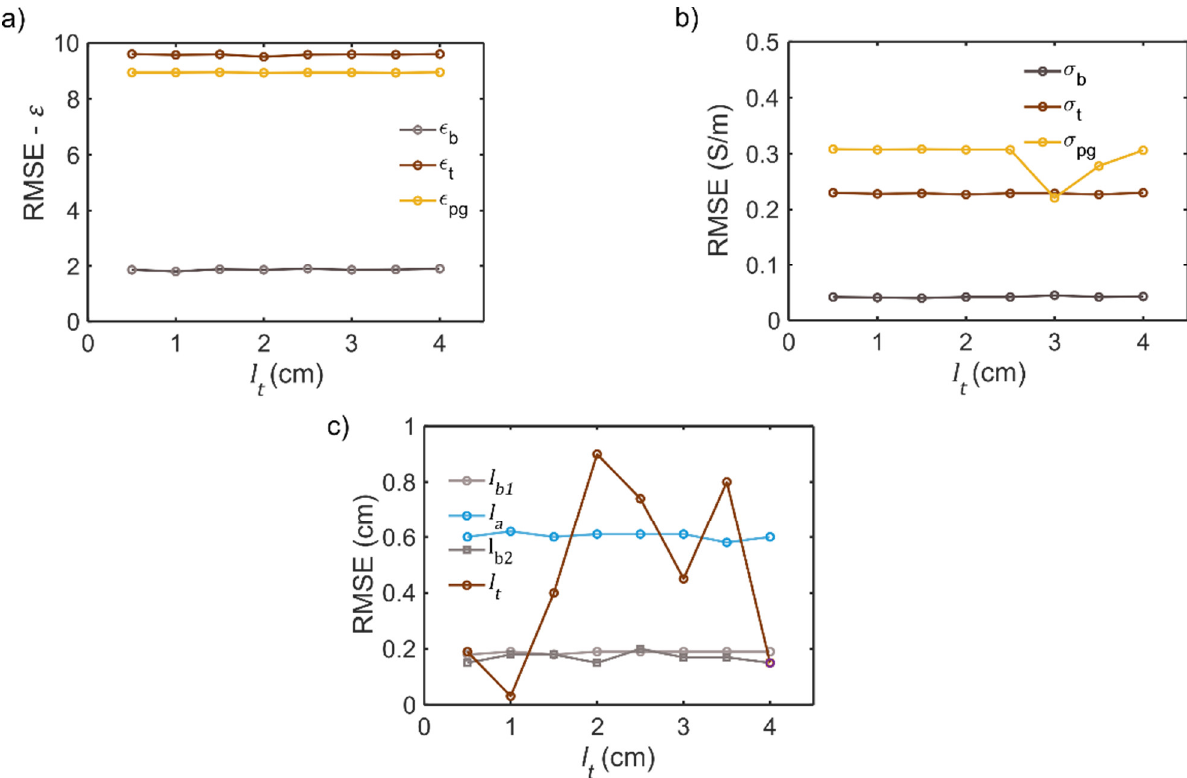
Figure 7. ( a ) RMSE for the three unknown permittivity values for different sizes of the pituitary tumor layer. ( b ) RMSE for the three unknown electrical conductivity values, in S/m, for different sizes of the pituitary tumor layer. ( c ) RMSE for lengths, in cm, of the tissue layers as a function of the pituitary tumor size.